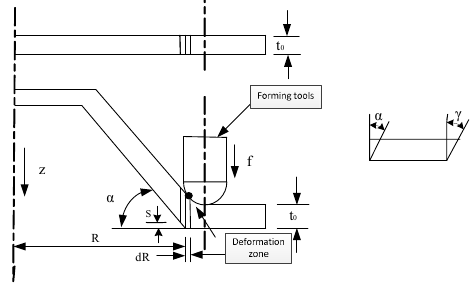
Figure 3. Schematic of the deformation.